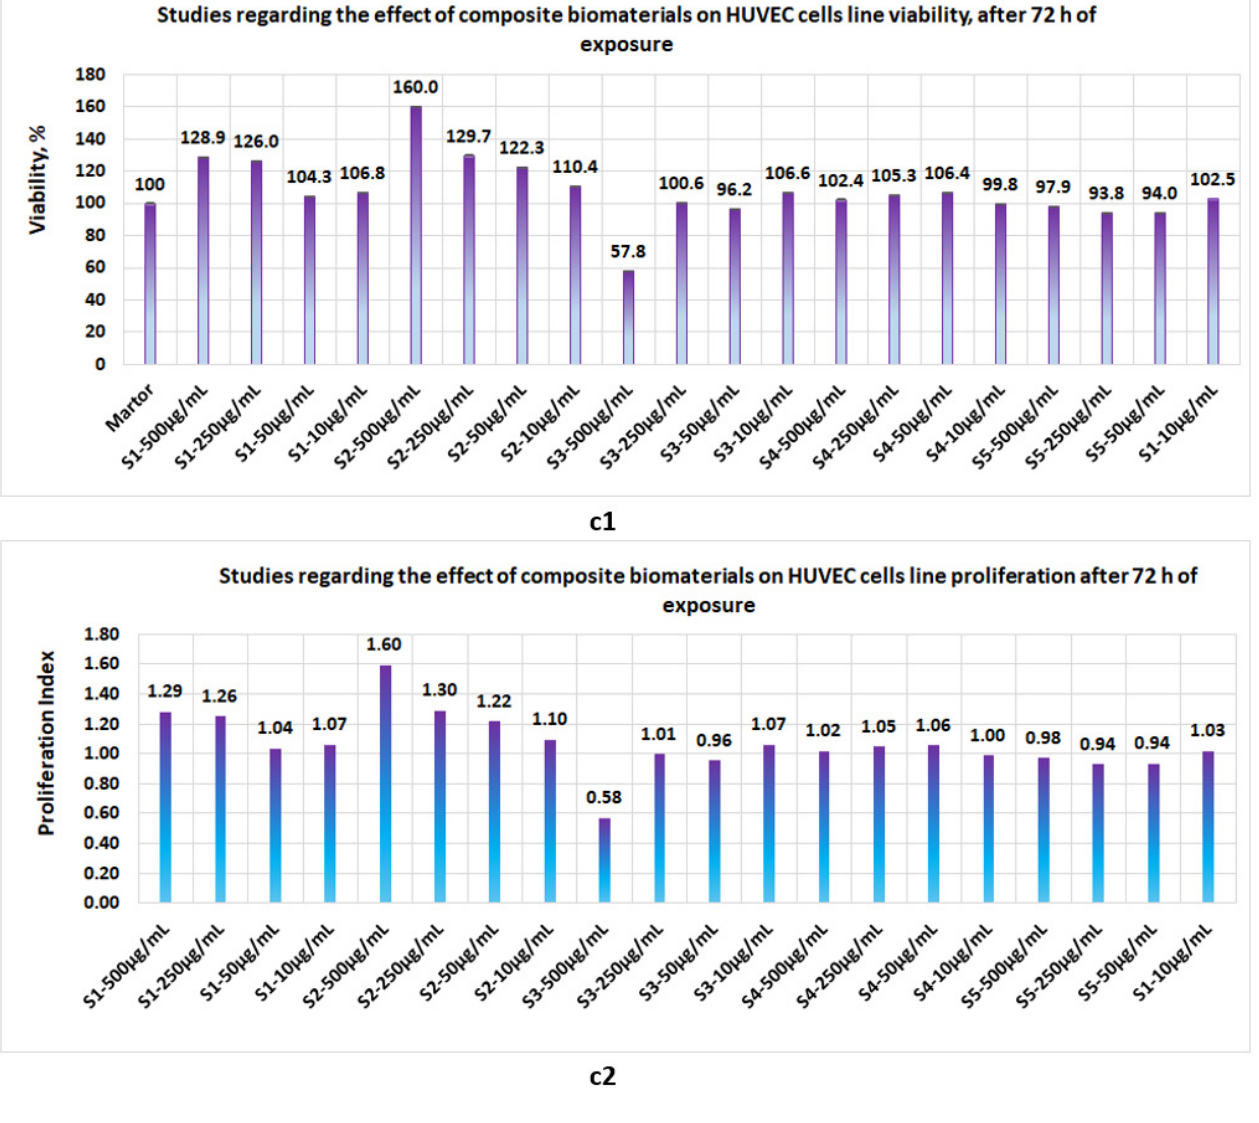
Figure 14. Studies regarding the effect of composite biomaterials on HUVEC cell lines after 72 h of exposure; ( c1 ) influence on cell viability; ( c2 ) influence on cell proliferation.